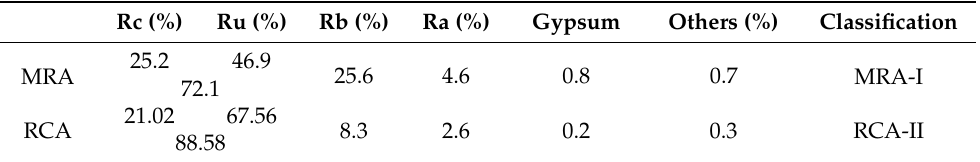
Table 2. Constituents of recycled aggregates according to EN 933-11